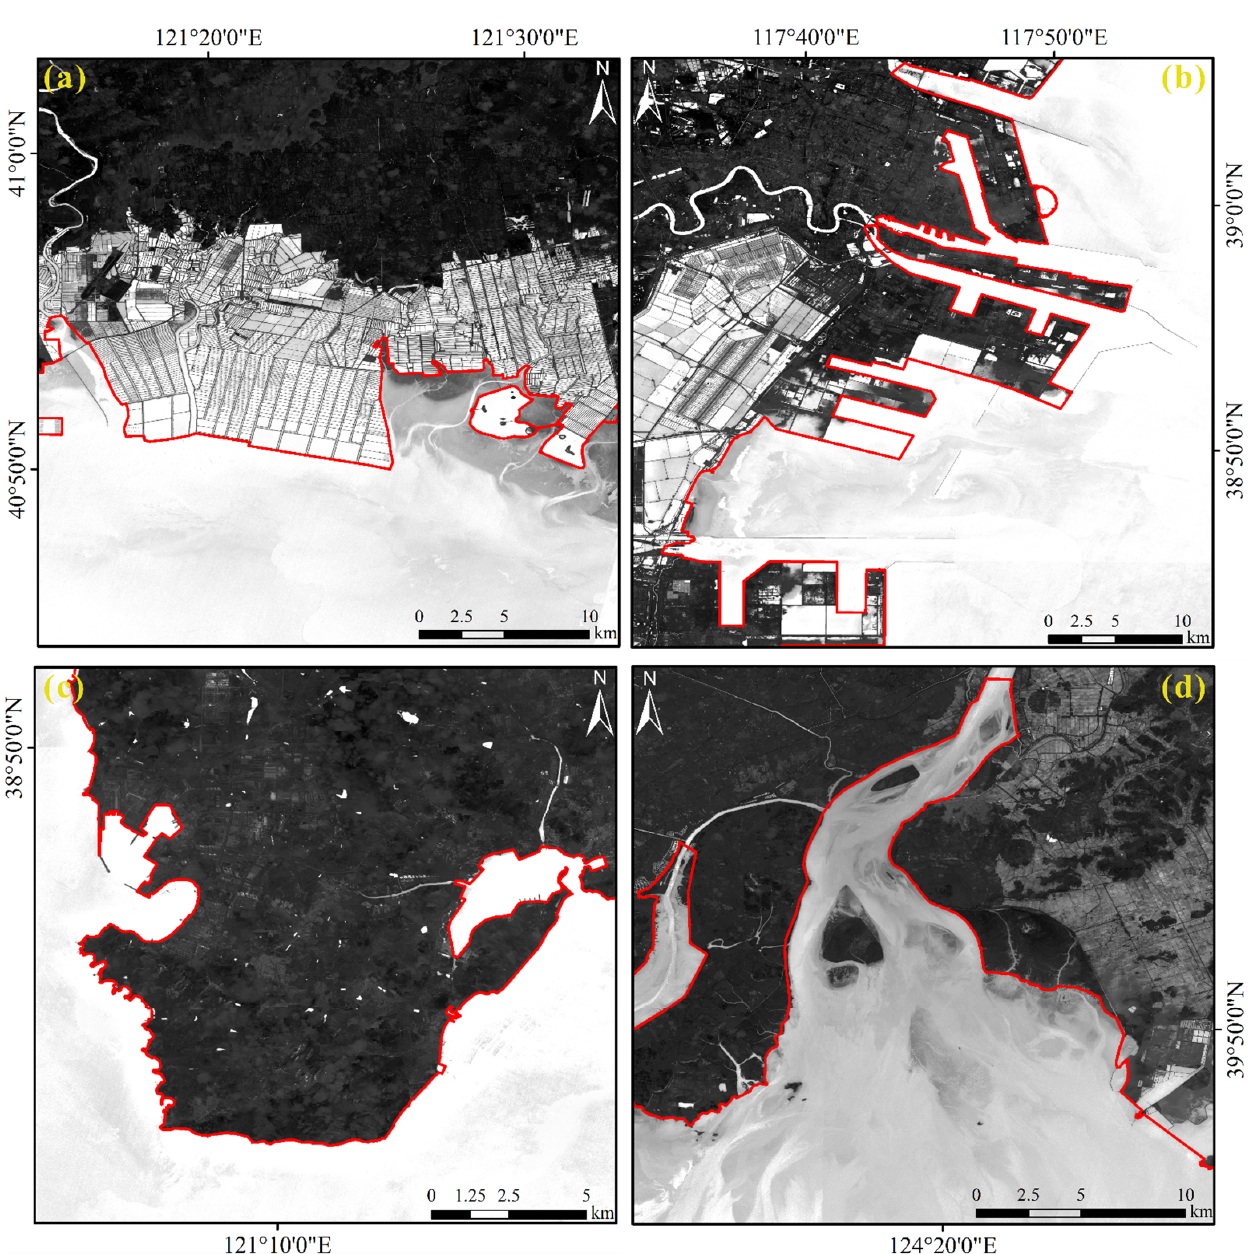
Figure 4. Adjusted water–land boundary of different types (red line). ( a ) Aquaculture ponds; ( b ) coastal industrial area; ( c ) rocky coast; ( d ) estuaries. The underlying picture is the NDWI maximum composite image (in grey scale).